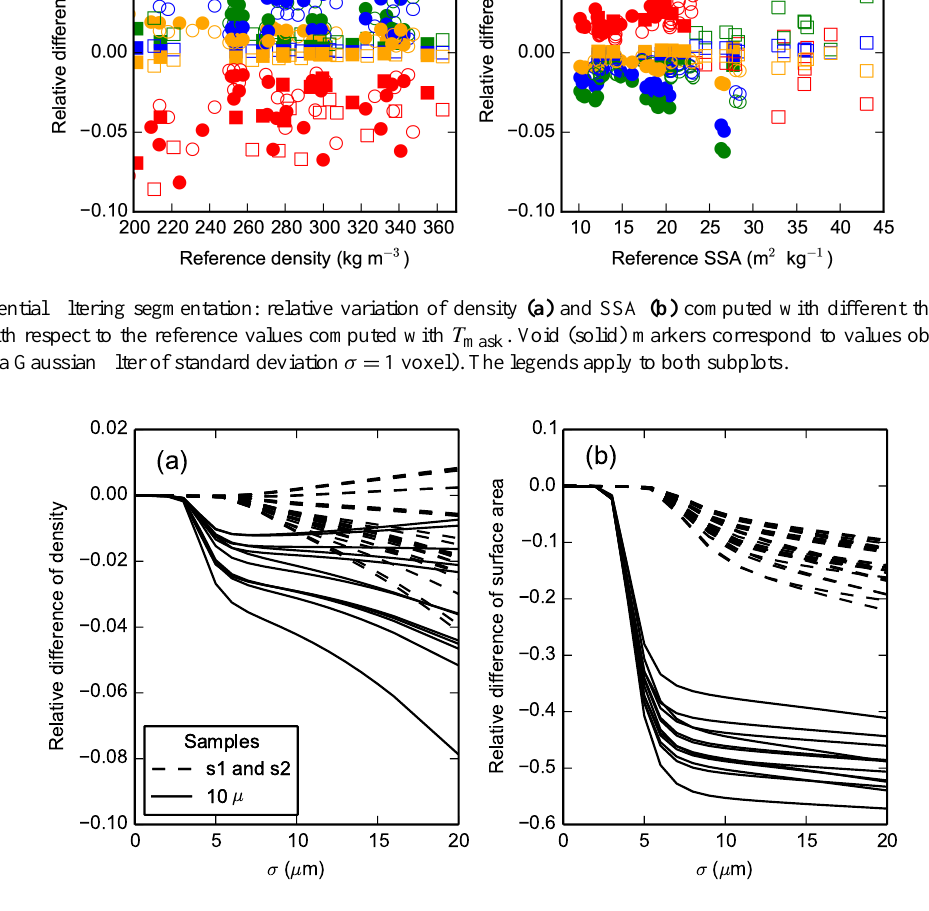
Figure 11. Sequential filtering segmentation: relative variations of density (a) and surface area (b) with the size σ of the Gaussian filter. The variations are calculated with respect to density and surface area obtained without a smoothing filter ( σ =